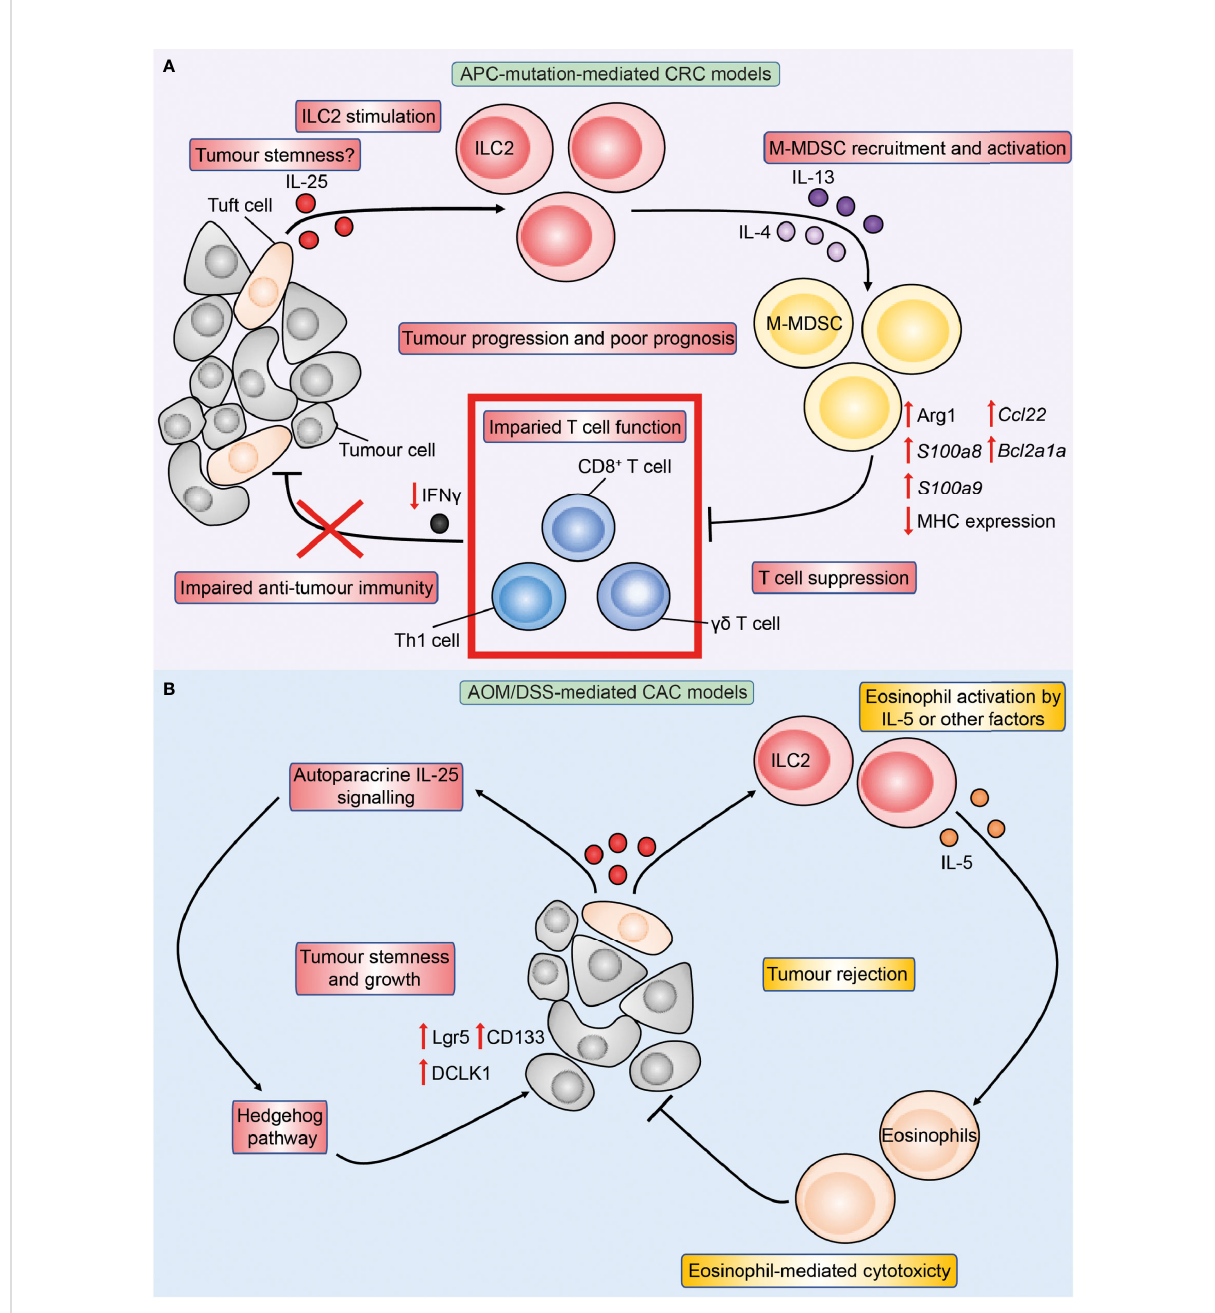
FIGURE 3 Overview of IL-25 in APC-mutation-mediated CRC and colitis-associated cancer (CAC) models. Figure depicts the immune-regulatory role of IL-25 characterised in preclinical models of APC-mutation-mediated CRC (A) and CAC (B) . (A) In the intestinal tumour microenvironment, DCLK1 + tuft-like cells are the main source of IL-25, and the latter may in turn promote tumour stemness. IL-25 activates tumour IL-25R + ILC2s to produce IL-4 and IL-13, which increases arginase 1 (Arg1) expression in tumour M-MDSCs leading to enhanced M-MDSC suppressive capacity. M-MDSC-mediated T cell suppression reduces T cell proliferation and IFN g production, leading to impaired anti-tumour immunity and tumour progression. (B) In the AOM/DSS model of CAC, IL-25 reduces tumour burden through eosinophils. This may be via ILC2-derived IL-5 or other yet-to-be identi fi ed factors promoting eosinophil activation and cytotoxicity against tumours in a CD8 + T cell-independent manner. Conversely, IL-25 may act in an autoparacrine manner to promote tumour stemness characterised by upregulation of stem markers Lgr5, CD133 and DCLK1 downstream IL-25 signaling in a Hedgehog pathway-dependent